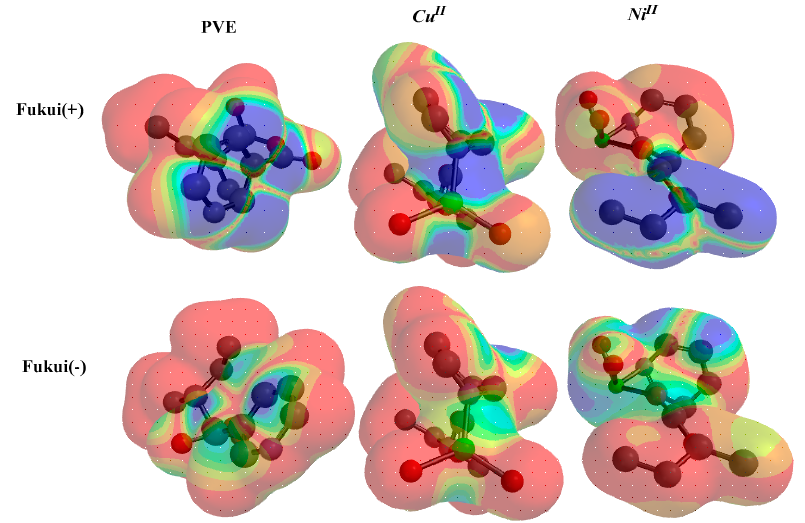
Figure 11. Fukui-function (electrophile and nucleophile) for PVE, Ni/PVA-NA and Cu/PVA-NA using DFT/BY3LP. The “ f + ”, signified by the red color corner, displayed the rise in electron density after gaining charge, while +Ve was represented by the blue color. In “ f − ”, the red site revealed reducing electron density after donating electrons. In PVA-NA, the C=O group has the most sensitive site against earning or contributing electrons (“ f − and f + ”). This observation showed that the electron cloud migrated between the pyridine ring and C=O, which caused the stabilization interaction with metal. The negative charges in Cu II , Ni II copolymers are more condensed over M-cores for both cases f − and f + , thus, the electron deported as pyridine → M-cores and enhanced the chelation power with dye. The variation in the density of charges where electrons were gained in the electronic system from dye “D” atom was represented by “ Δρ KElec “. When this mechanism is reversed, it can be represented as “ Δρ KNuc”.